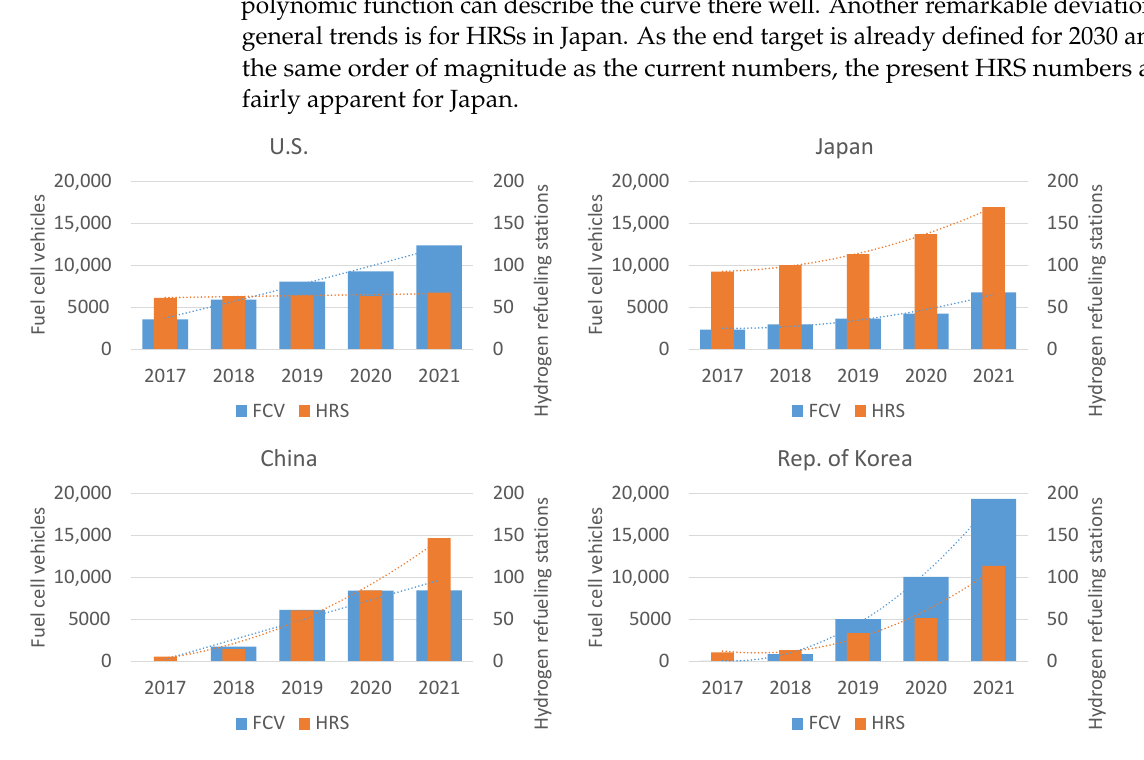
Figure 17. Comparative development trends of the numbers of FCVs and HRSs in the four countries with the highest numbers of FCVs on the road as of the end of 2021. In the next analysis, the development trends in the last five years will be combined with the announced roadmaps or national targets for the same countries. The Basic Plan for Implementing the Hydrogen Economy of Korea [113] defines targets for 2022, 2025, 2030, 2040, and 2050. The Roadmap to a U.S. Hydrogen Economy [114] sets milestones for 2022, 2025, and 2030. The Technology Roadmap for Energy-Saving and New Energy Ve- hicles [117] in China defines targets for 2025 and 2030–2035 and, similarly, the Strategic Road Map for Hydrogen and Fuel Cells [118] in Japan defines targets for 2025 and 2030. Due to different time scales and the resulting numerical targets in each of the four coun- tries, the axis windows could not be kept the same in each diagram in Figure 18 Error! Reference source not found. , which combines the achieved (2017–2021, this work and previous survey results) with the target numbers from the four sources mentioned above and discussed in detail in the previous section. To separate the realized numbers with those from the targets, the targets (2022–2050) are marked with dots in the figure. As the realized numbers are relatively low compared to the target numbers, in most of the cases third-degree polynomials are required to draw the trend lines combining the present numbers with the plans. One exception is the case for HRSs in South Korea. As the targets are defined for many more years, a second-degree polynomic function can describe the curve there well. Another remarkable deviation in the general trends is for HRSs in Japan. As the end target is already defined for 2030 and is on the same order of magnitude as the current numbers, the present HRS numbers are also fairly apparent for Japan.